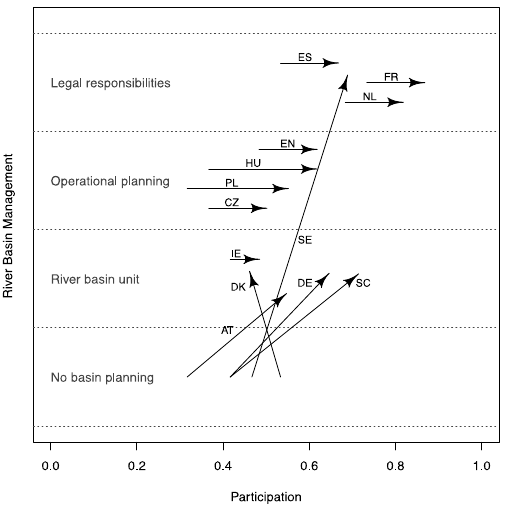
Figure 1. Trajectories of WFD-related governance change in 13 EU member states: AT = Austria; CZ = Czech Republic; DE = Germany; DK = Denmark; EN = England and Wales; ES = Spain; FR = France; HU = Hungary; IE = Ireland; NL = Netherlands; PL = Poland; SC = Scotland; and SE = Sweden. The x-axis is a four-dimensional “degree of participation” index, described in Section 3 and the Supplementary Material. The y-axis is not to be read as a continuous scale, and no distinction is to be made between the position of member states within a given stage or band on the y-axis (arrows have been spaced for presentation and ease of interpretation only).